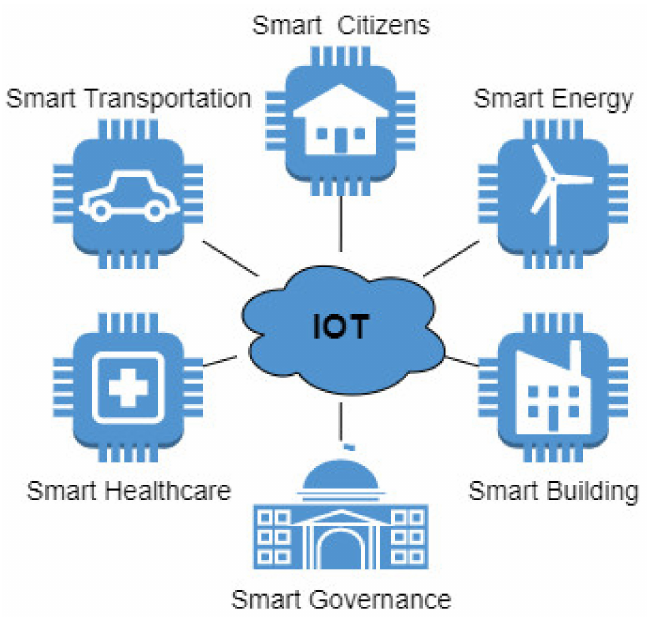
Figure 1. Smart City digitalization strategy goals. Table 1. Literature overview for blockchain as a Smart City